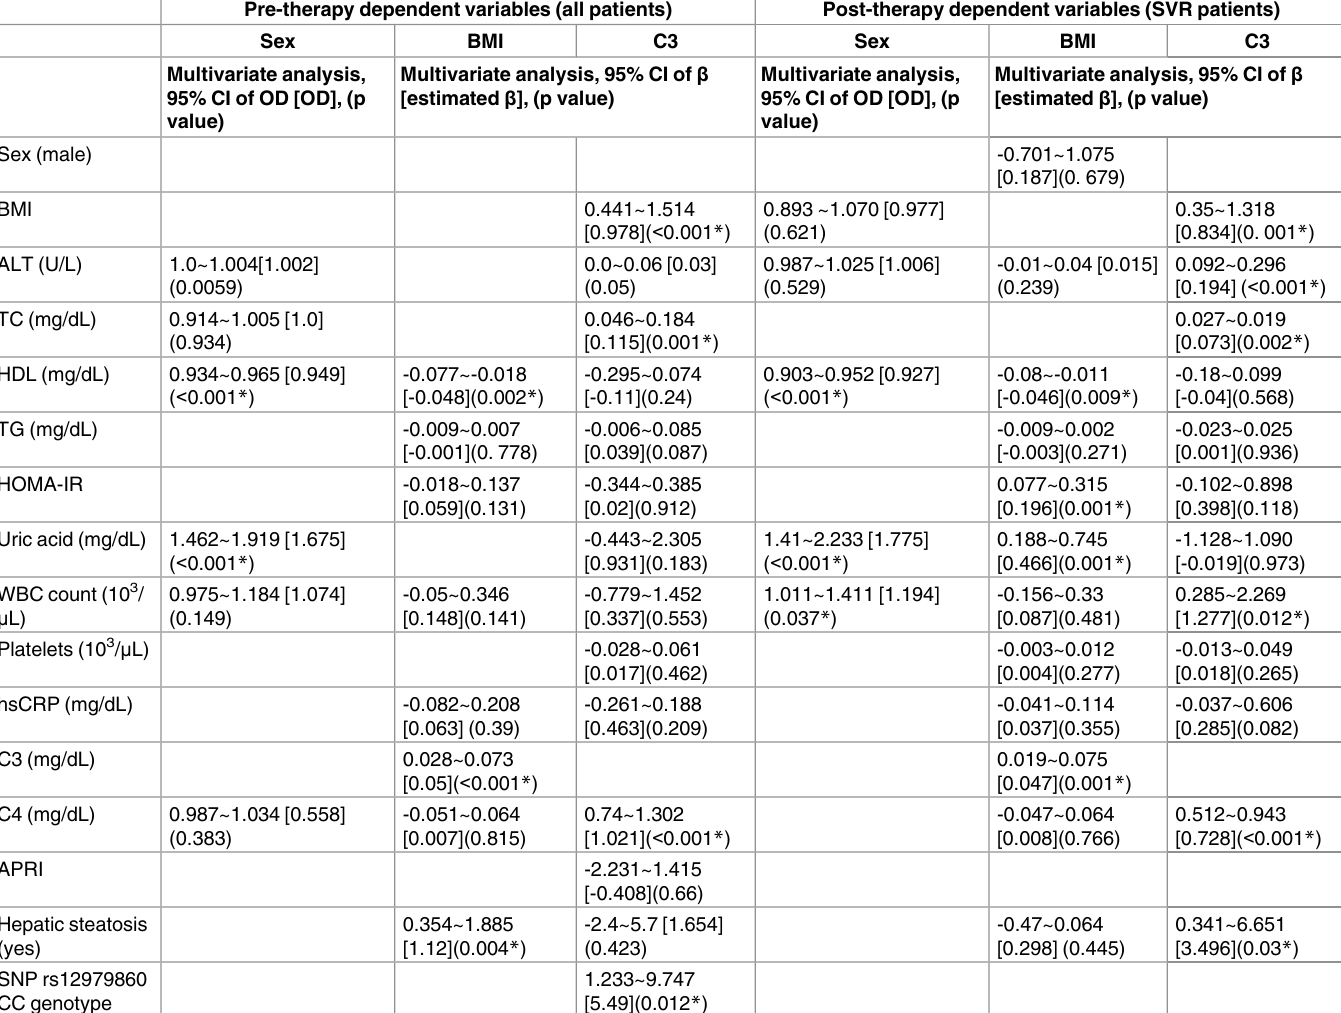
Table 3. Multivariate analysesof factors associated with pre- and post-therapy sex, BMI, and C3 levels. Pre-therapy dependent variables (all